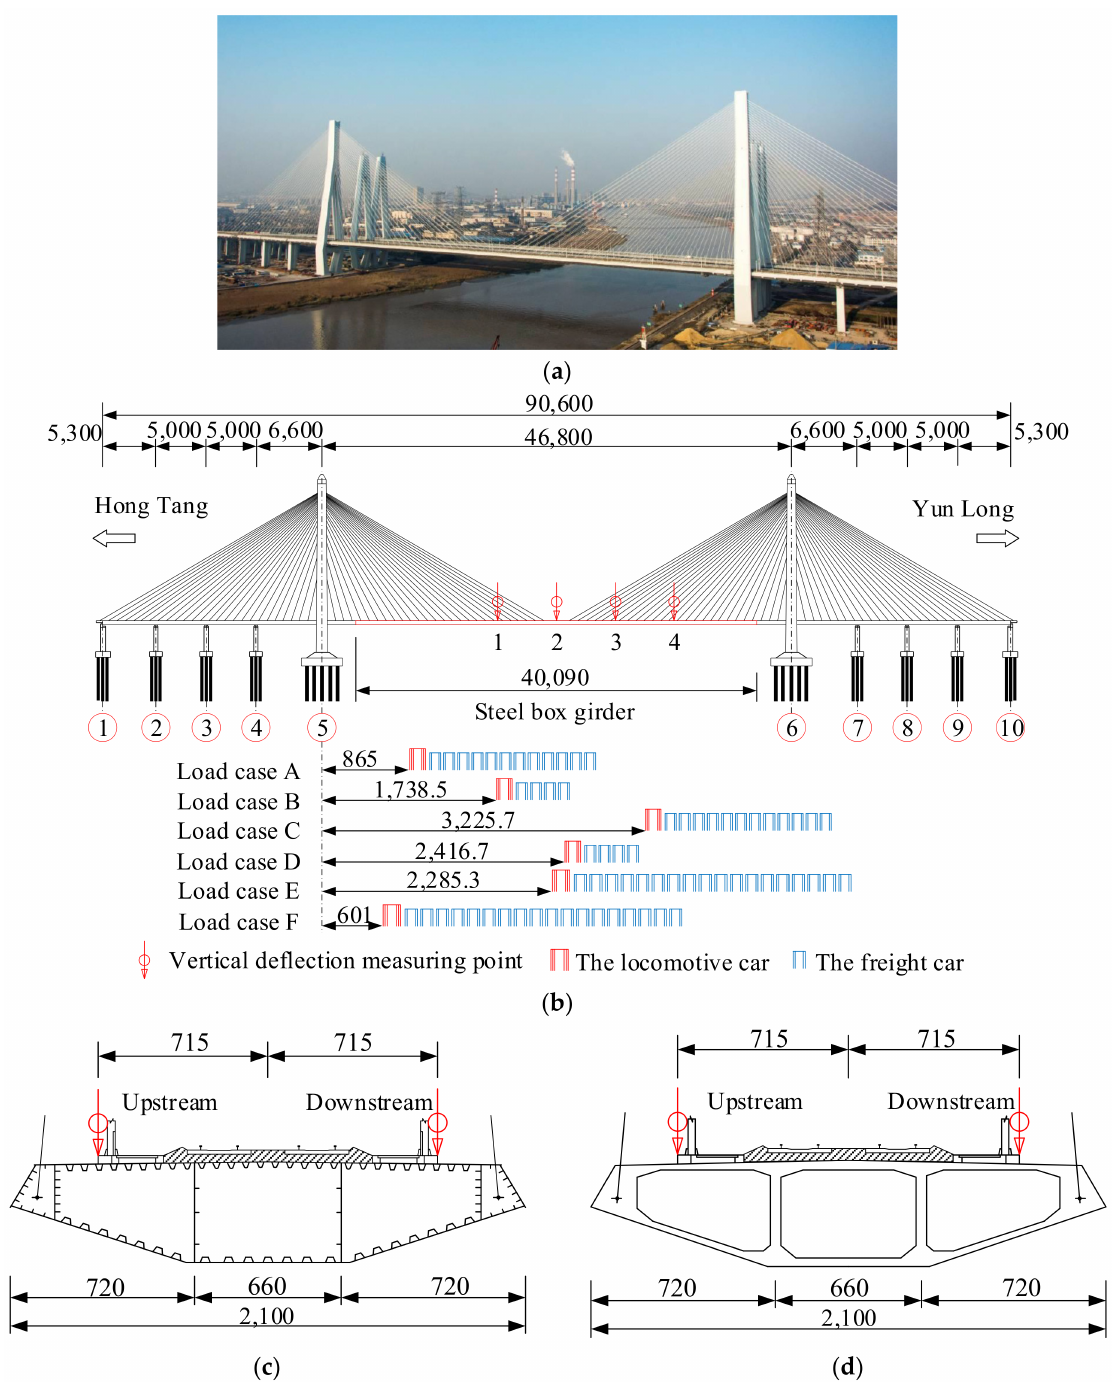
Figure 7. The Yongjiang Bridge: ( a ) overview; ( b ) the elevation layout; ( c) the section layout of the steel box girder; and ( d ) the section layout of the concrete box girder. (Unit: